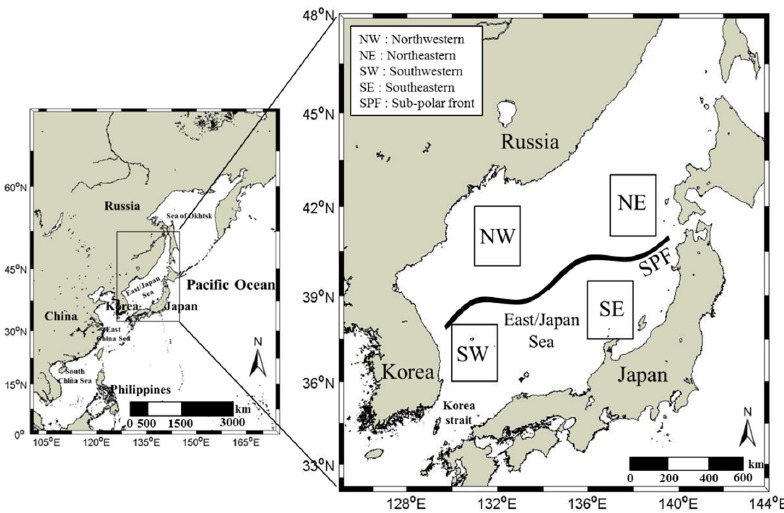
Figure 1. Study site in the East Sea (NW = northwestern, NE = northeastern, SW = southwestern, and SE = southeastern). SPF stands for the sub-polar front.